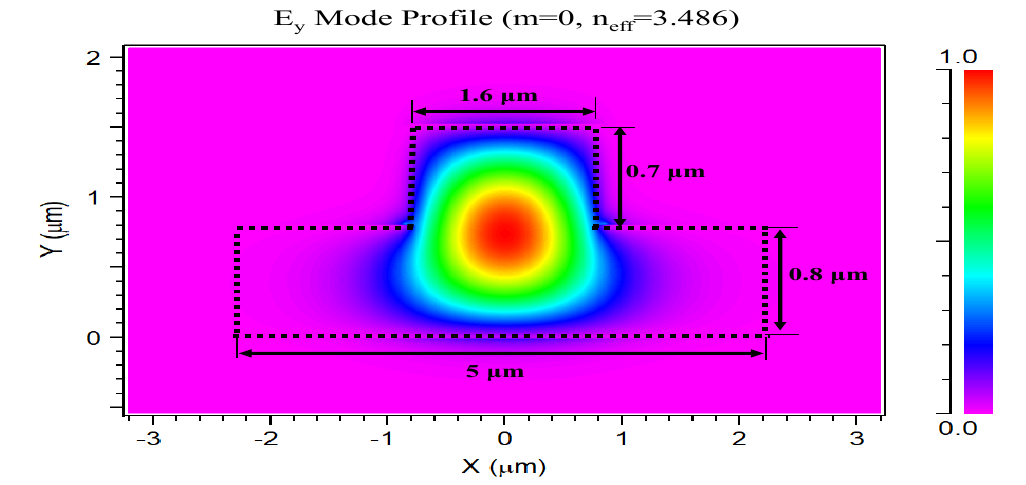
Figure 4. Mode profile of the waveguide (dotted line shows the cross-sectional dimensions of the waveguide